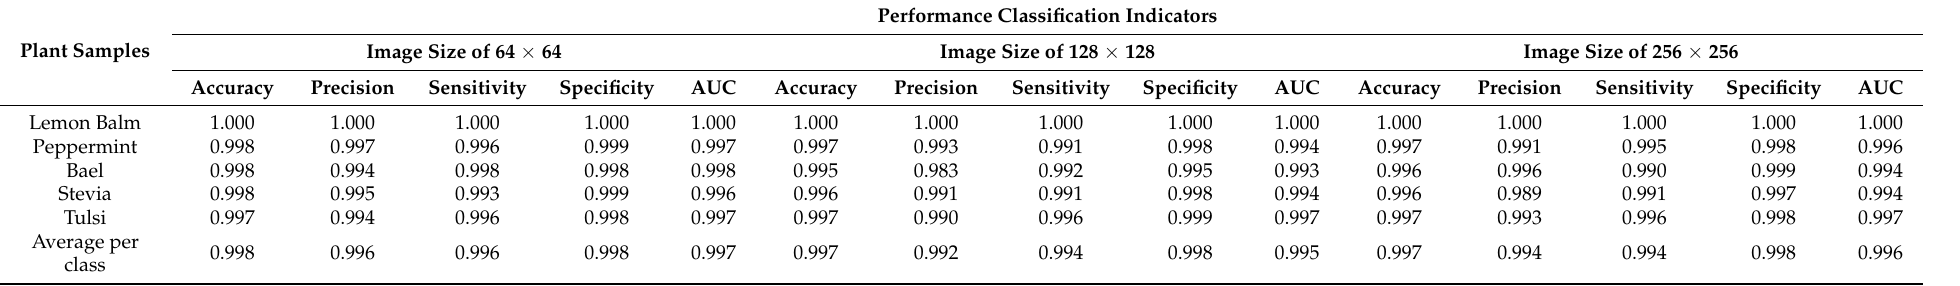
Table 2. The performance results of medicinal plant classification obtained from the proposed CNN